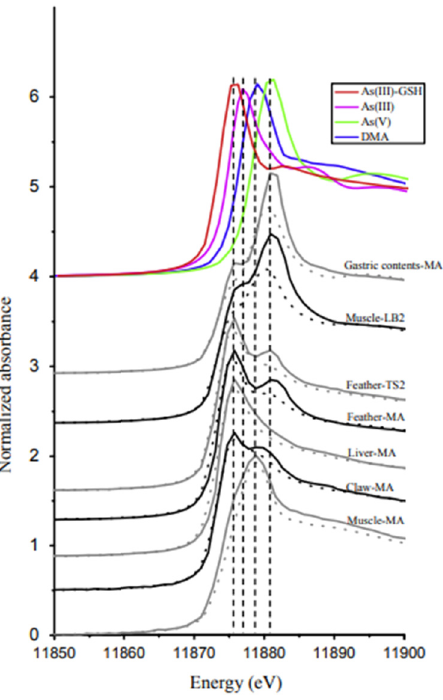
Figure 2: XANES raw data (- - -) and fi tting ( — ) for model As species and samples.